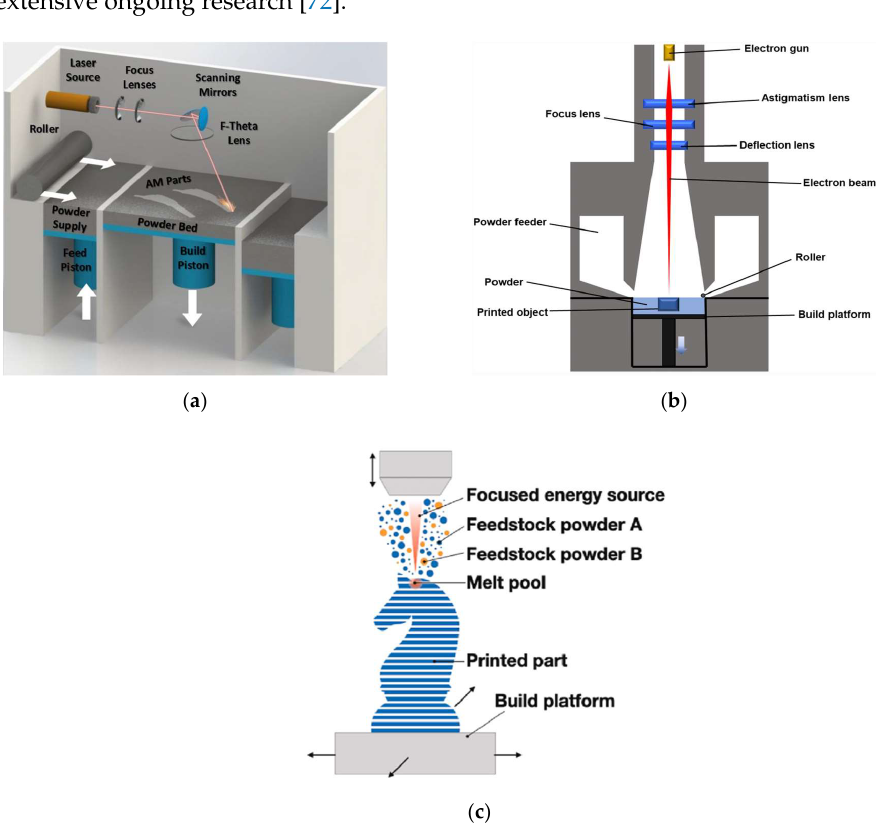
Figure 1. ( a ) Laser Powder Bed Fusion (PBF-LB) process [73] (Reprinted with permission from [73]. Copyright 2018, Elsevier). ( b ) Electron Beam-Powder Bed Fusion (PBF-EB) process [74] (Reprinted with permission from [74]. Copyright 2020, Springer Nature). ( c ) Direct Energy Deposition (DED) process [75] (Reprinted with permission from [75]. Copyright 2022, Elsevier).